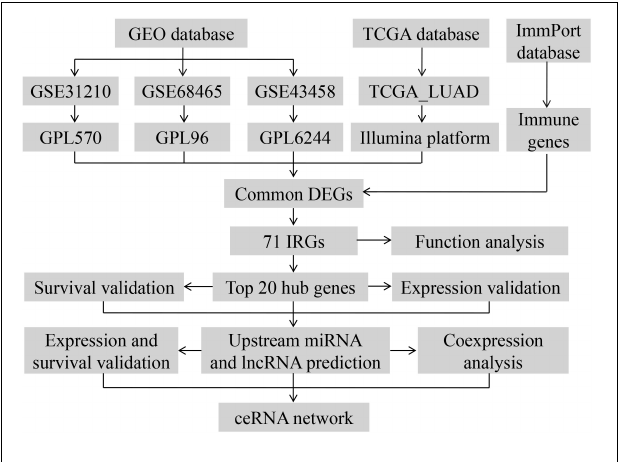
FIGURE 1 | Workflow presenting the process of establishing the immune-related ceRNA network in lung adenocarcinoma.